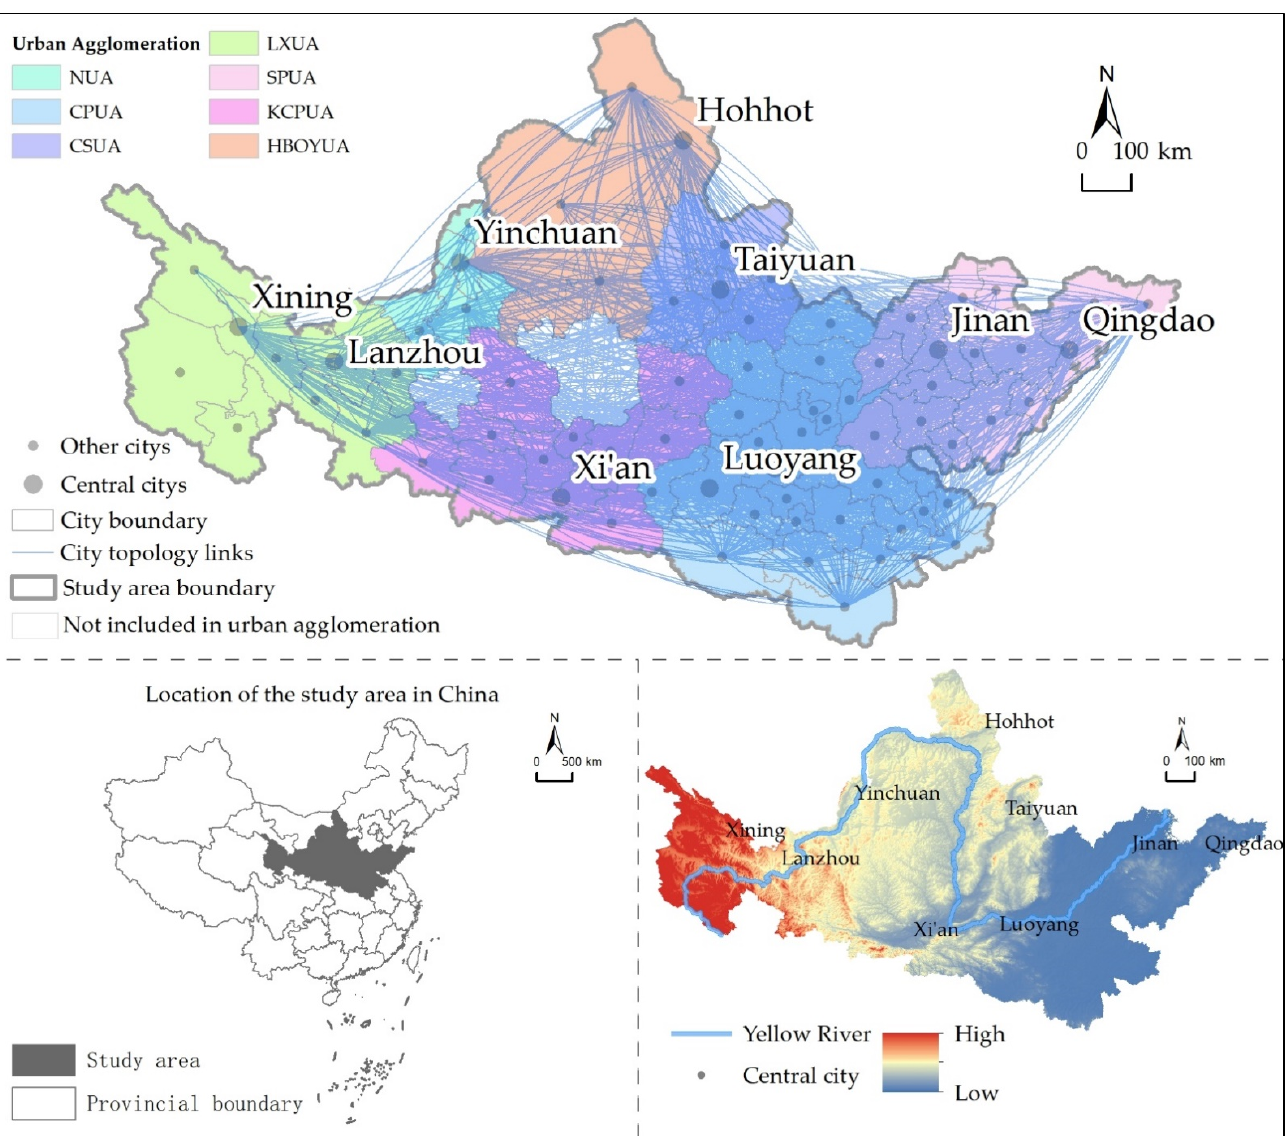
Figure 2. Overview of the study area.